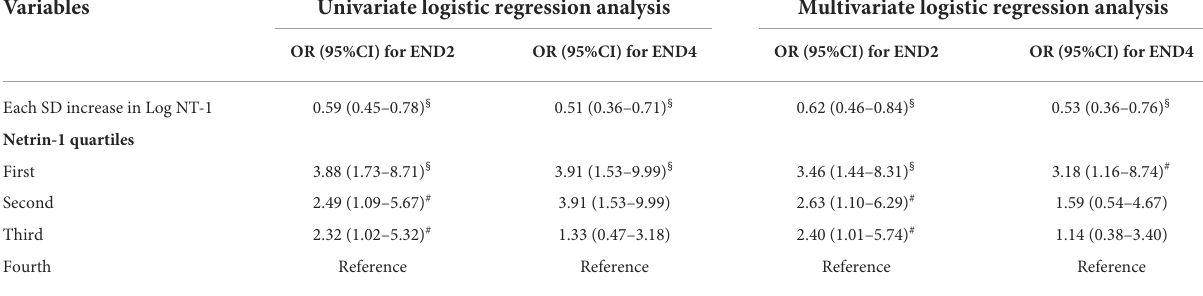
TABLE 3 Multivariate analysis of the association between netrin-1 levels and early neurological